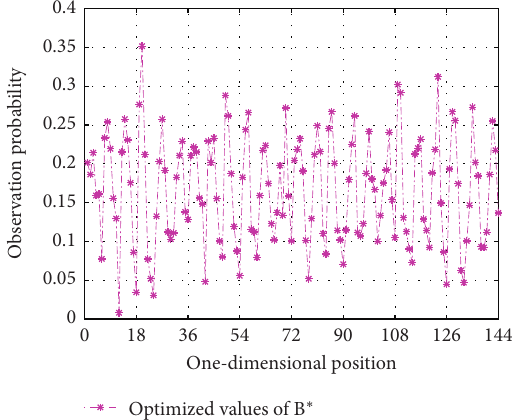
Figure 9: One-dimensional distribution of the optimized values of B ∗